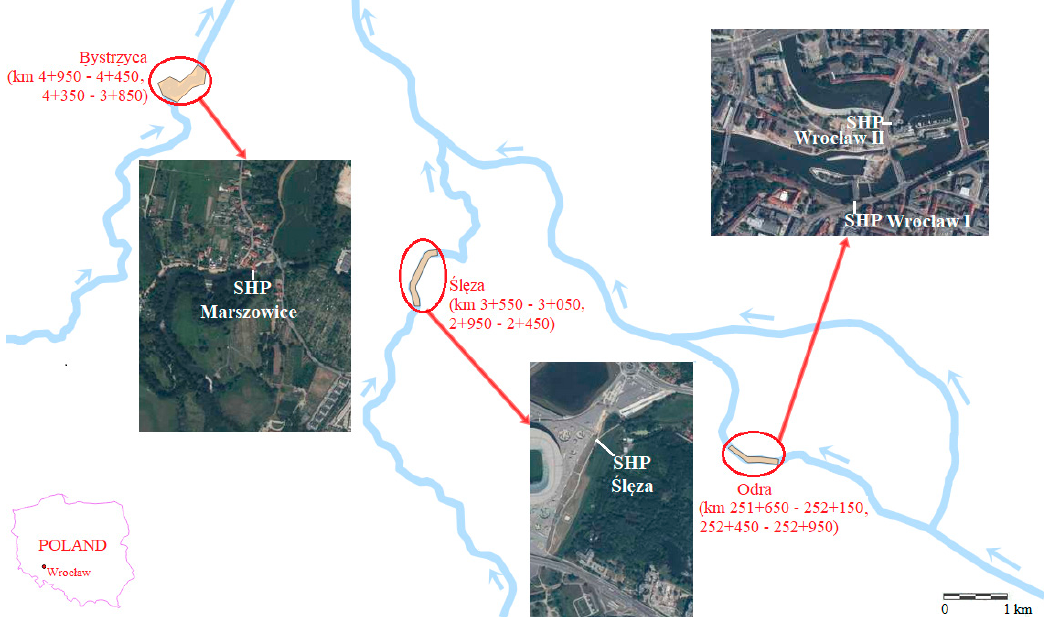
Figure 1. The location of the research sections in RHS—above and below the SHP (the rivers Odra, Ś l ę za, and Bystrzyca).